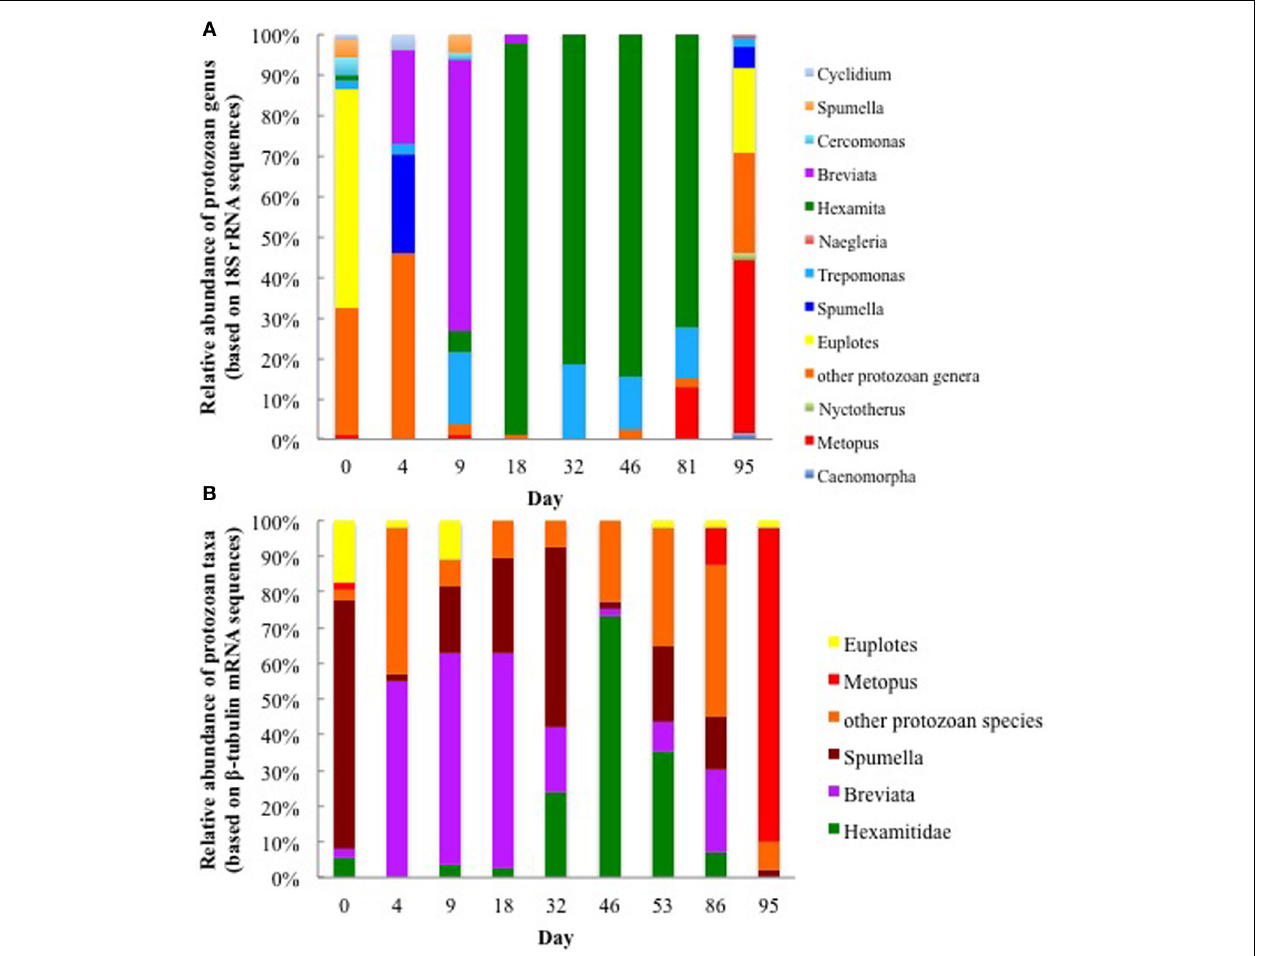
FIGURE 2 | Relative abundance of various protozoan taxa found in groundwater collected on various days during the 2011 field experiment based on (A) protozoan 18S rRNA transcripts and (B) ß-tubulin mRNA